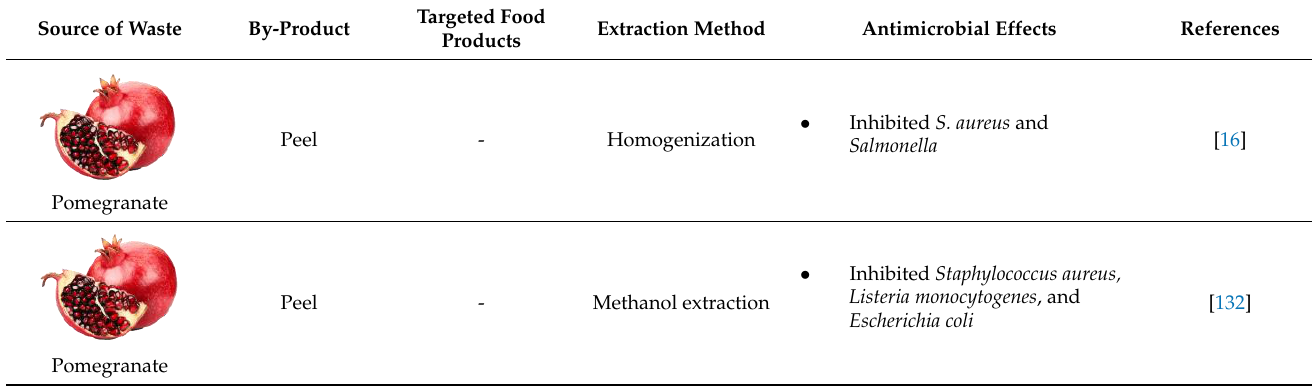
Table 3. Usage of peel waste as antimicrobial in food applications.